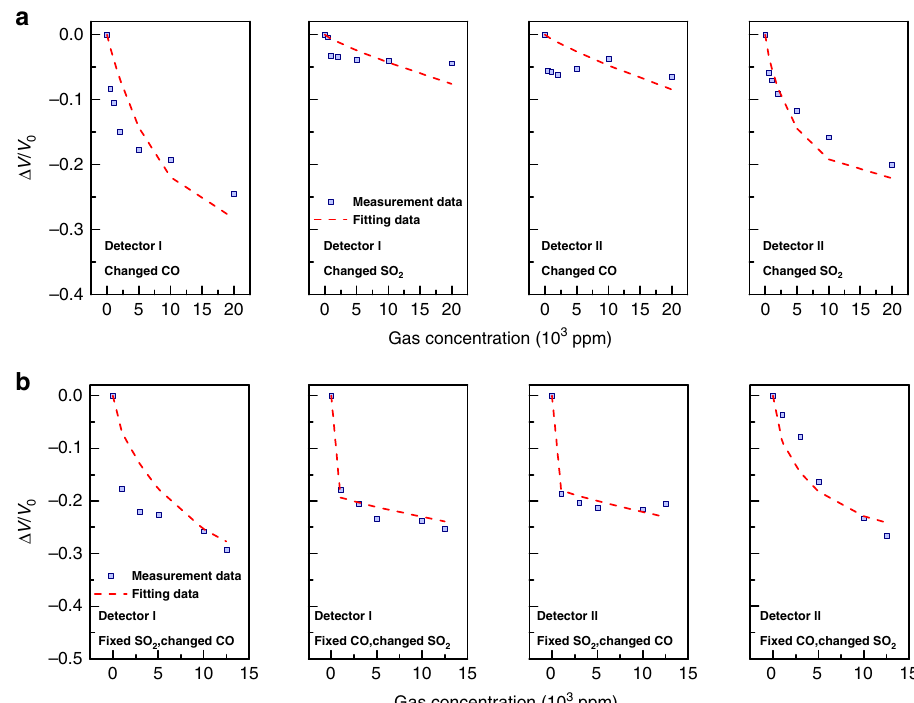
Fig. 6 The NDIR experiment on two target gases measured by two narrowband detectors. a The detector responses of four single-target gas measurements: CO measured by detector I; SO 2 measured by detector I; CO measured by detector II; SO 2 measured by detector II, respectively. b The detector responses of four mixed-gas experiments: fi xed SO 2 concentration and varying CO concentration measured by detector I; fi xed CO concentration and varying SO 2 concentration measured by detector I; fi xed SO 2 concentration and varying CO concentration measured by detector II; fi xed CO concentration and varying SO 2 concentration measured by detector II, respectively. In each mixed-gas experiment, the fi xed concentration is chosen to be 7500 ppm. The purple squares stand for the measured detector responses while the red dashed lines are the calculated detector responses based on the mathematical models provide by Eq. (3) and Eq. (4). Source data are provided as a Source Data fi